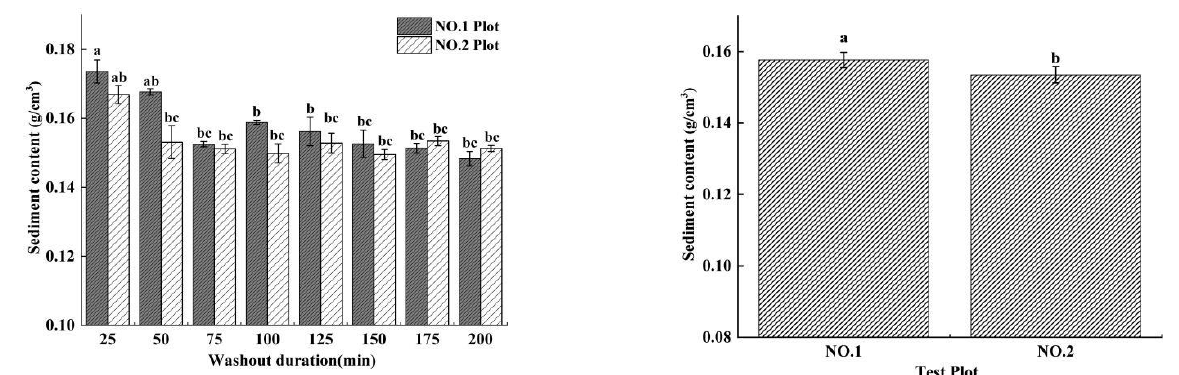
Figure 9. Average and total sediment content of short-term rainfall and moderate rainfall experiments.